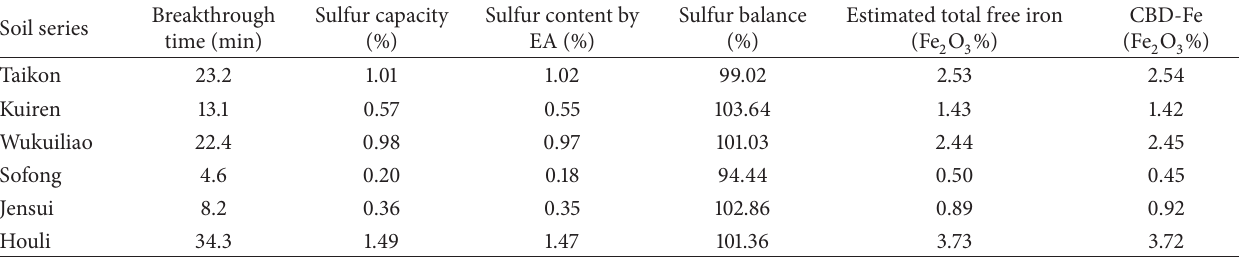
Table 5: The sulfur capacities and estimated total free iron of six representative soil samples at 773 K under the experimental condition of 50%